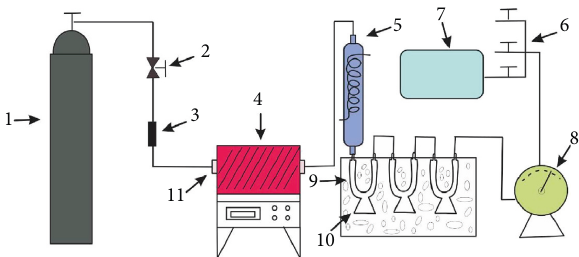
Figure 1: Schematic diagram of fixed-bed pyrolysis